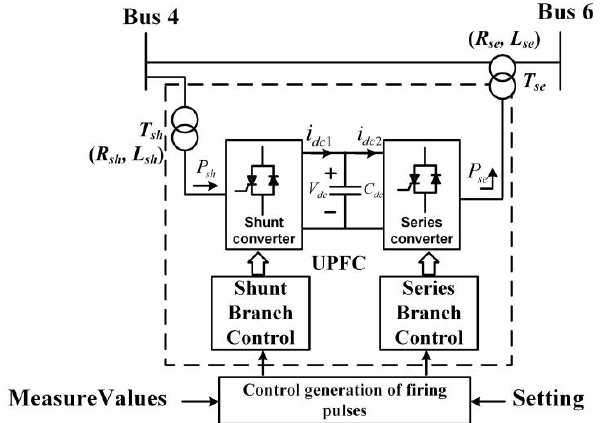
Figure 2. UPFC architecture model connected between Bus 4 and Bus 6.